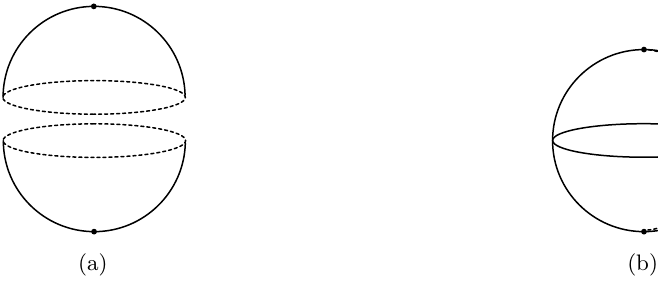
Figure 17 . Radial and Angular Slicings . The same Euclidean functional integral on a sphere may be assigned different Hilbert space interpretations by choosing different foliations. In radial quantization (left), one slices the sphere into circles centered at the poles. Each circle is a spatial slice, and Euclidean time flows along the radial direction transverse to the slices. Then the functional integral over the sphere computes the inner-product of the states prepared by the operator insertions at the poles in the Hilbert space e.g. on the equatorial circle. In angular quantization, the spatial slices are instead radial lines connecting the poles, and Euclidean time flows along the angular direction. Then the same two-point function on the sphere computes the thermal trace in the angularly quantized Hilbert space on the dashed line. Given a point on the sphere, its spatial slice in radial quantization is the orbit of the rotation generator, and its Euclidean time evolution is the orbit of the dilation generator. In angular quantization, the roles of the two symmetries are